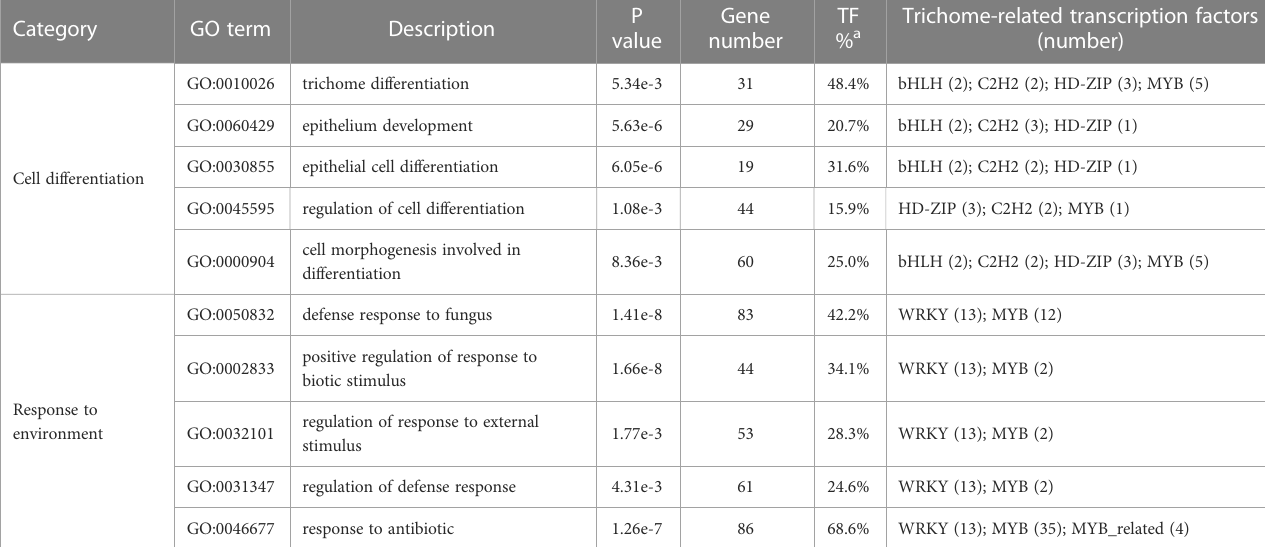
TABLE 3 GO enrichment analysis result of signi fi cantly expanded gene families in the common ancestor of Melastoma candidum and M. dodecandrum .